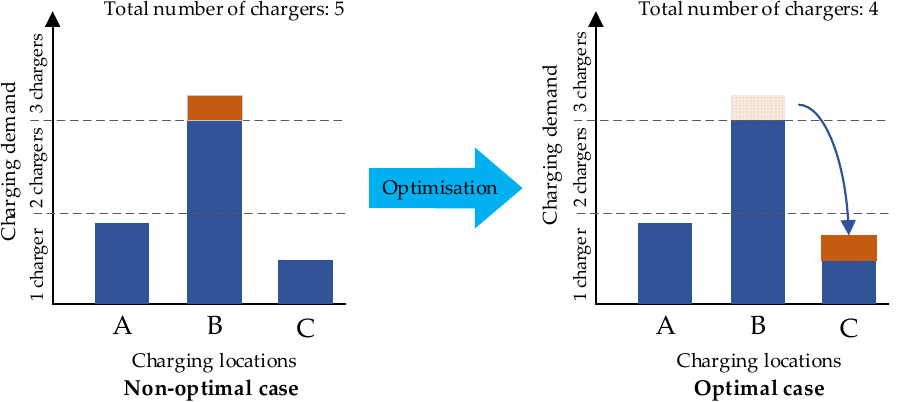
Figure 1. Reallocation of charging demand to reduce the total number of chargers.